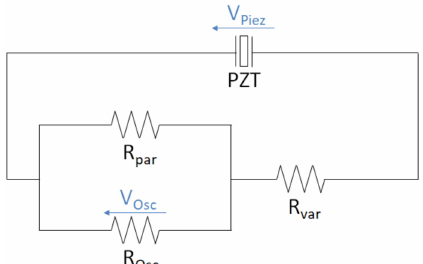
Figure 4. Measuring circuit of the piezoelectric element (PZT) for different load resistances with a voltage divider and an oscilloscope.